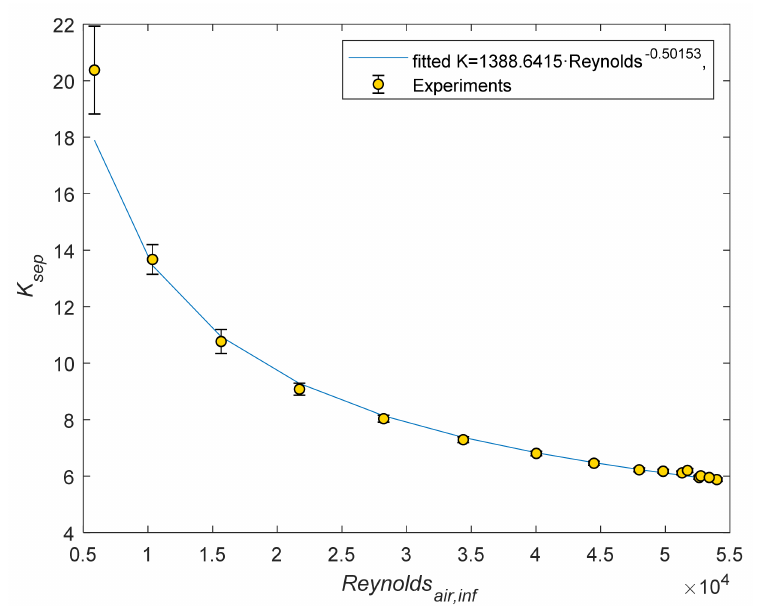
Figure 3. Calculated loss coefficient for different Reynolds numbers and fitted